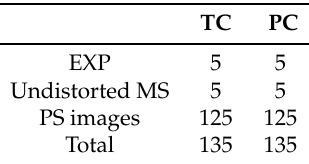
Table 1. Description of images employed in the subjective study. TC, true color; PC, pseudo-color; MS, multi-spectral; PS,